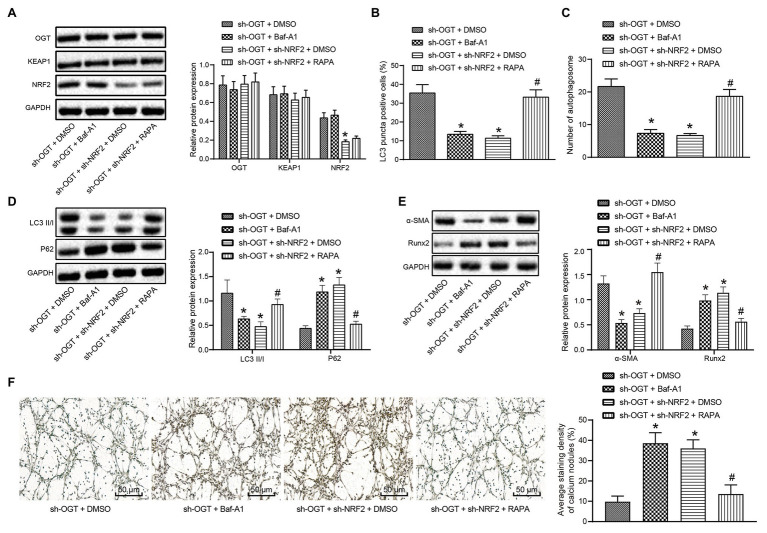
OGT accelerates VSMC calcification by curbing cell autophagy via the KEAP1/NRF2 axis. (A) Western blot analysis of protein levels of OGT, KEAP1, and NRF2 normalized to GAPDH in response to OGT knockdown, NRF2 knockdown, bafilomycin A1 (Baf-A1), and rapamycin (RAPA). (B) Quantitative analysis of immunofluorescence assay for proportion of LC3-positive cells in response to OGT knockdown, NRF2 knockdown, Baf-A1, and RAPA. (C) Quantitative analysis of autophagosomes formation in response to OGT knockdown, NRF2 knockdown, Baf-A1, and RAPA. (D) Western blot analysis of autophagy-related proteins LC3II/I, and P62 normalized to GAPDH in response to OGT knockdown, NRF2 knockdown, Baf-A1, and RAPA. (E) Western blot analysis of calcification-related proteins Runx2 and α-SMA normalized to GAPDH in response to OGT knockdown, NRF2 knockdown, Baf-A1, and RAPA. (F) Von Kossa staining and quantitative analysis showing calcium deposition of VSMCs in response to OGT knockdown, NRF2 knockdown, Baf-A1, and RAPA. *p < 0.05 vs. cells transduced with sh-OGT + DMSO. #p < 0.05 vs. cells transduced with sh-OGT + sh-NRF2 + DMSO (in vitro experiments were repeated three times independently).